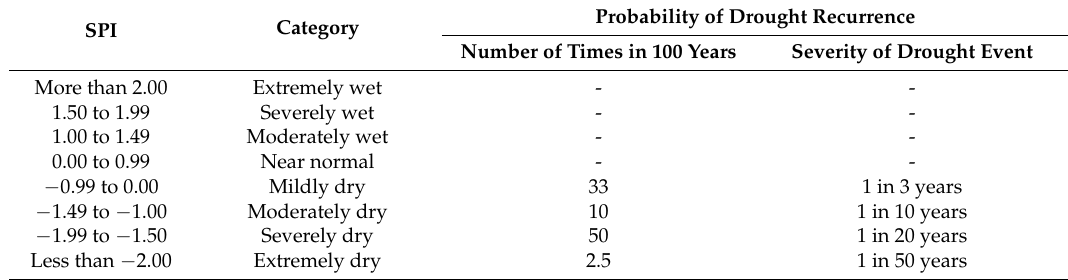
Table 2. Drought categories from standardized precipitation index (SPI) and standardized precipitation evapotranspiration index (SPEI) values.